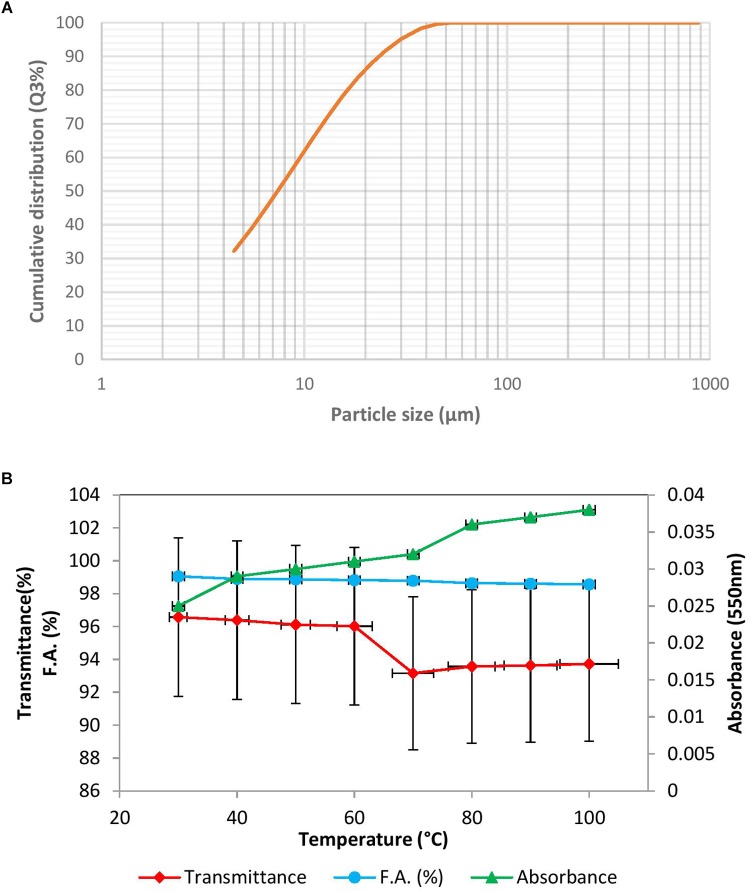
(A) Floc size in the presence of BF-VB2 depicted as a graph between particle size and cumulative distribution. (B) Thermal stability studies; effect of varying temperature on the flocculation activity of bioflocculant BF-VB2. Results are average value of triplicates and error bars represent standard deviation.